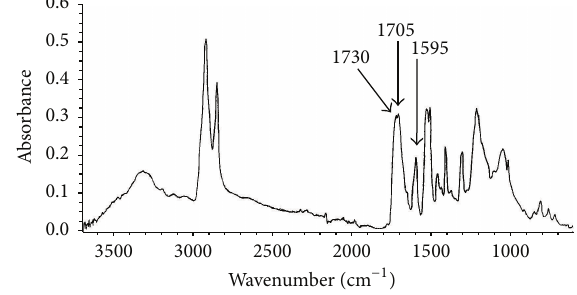
Figure 1: IR spectra of waste vegetable oil (bold line) and the corresponding biorenewable polyol (dotted line).